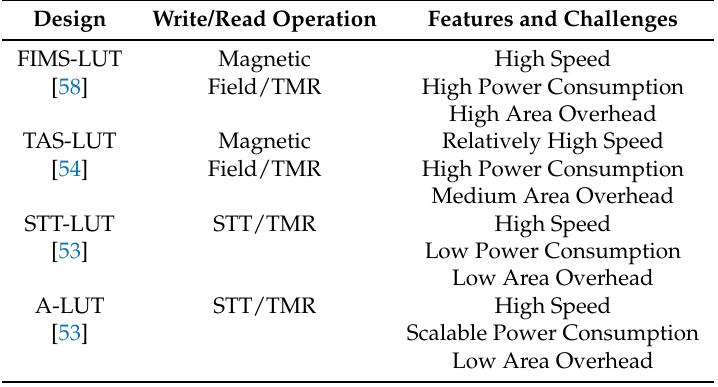
Table 5. Characteristics of LUT